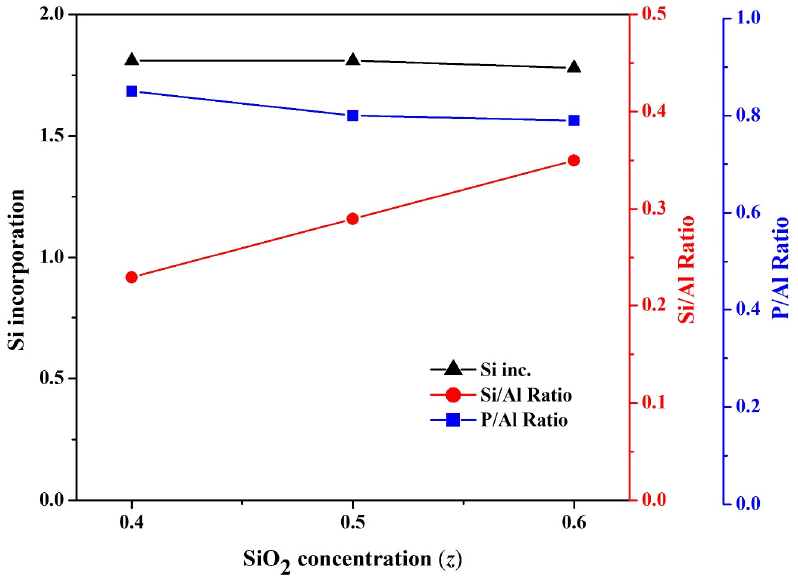
Figure 9. The effect of SiO 2 concentration ( z ) in the gel solution on the Si/Al ratio, P/Al ratio, and Si incorporation for the synthesized SAPO-34 particles.